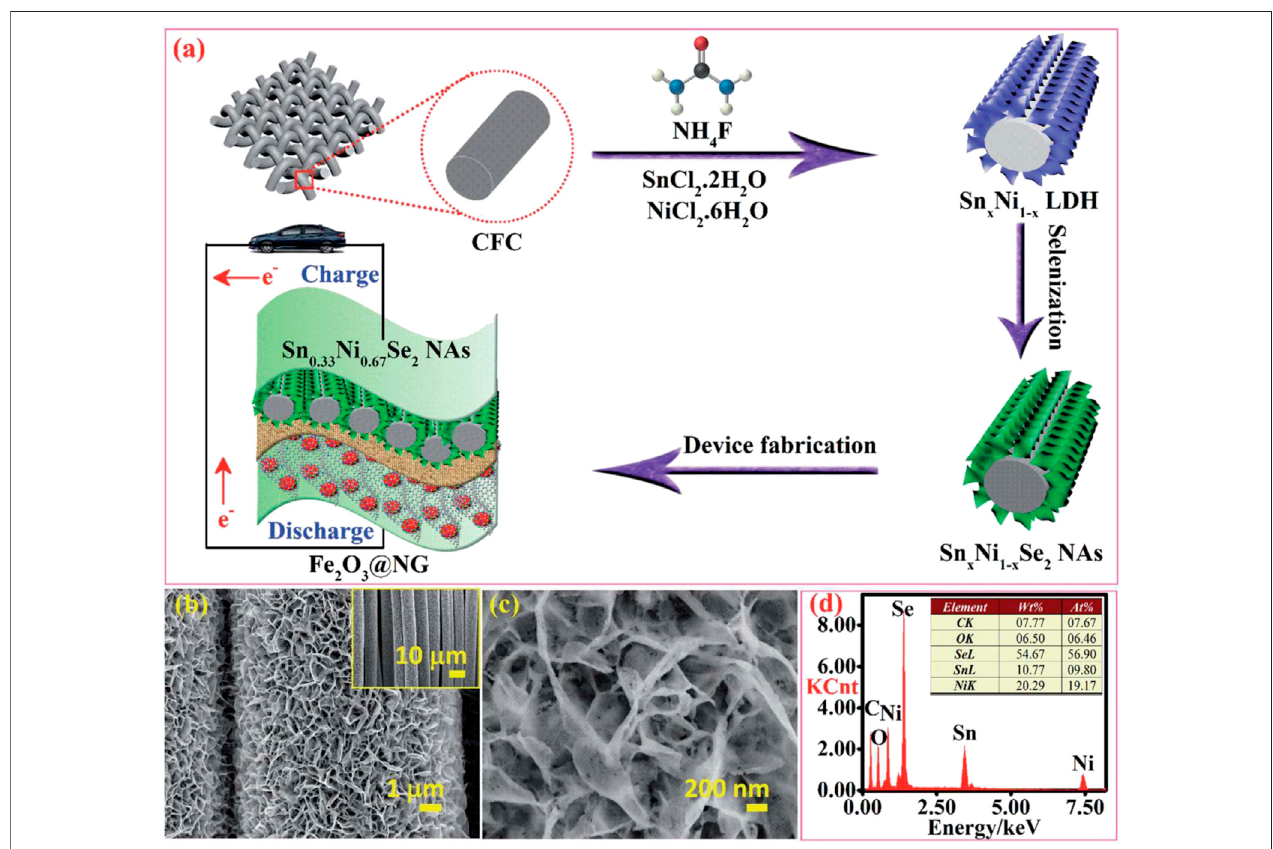
FIGURE 15 | Nickel-tin selenide (Sn x Ni 1-x Se 2 ; 0 < x < 1) on carbon fi ber.